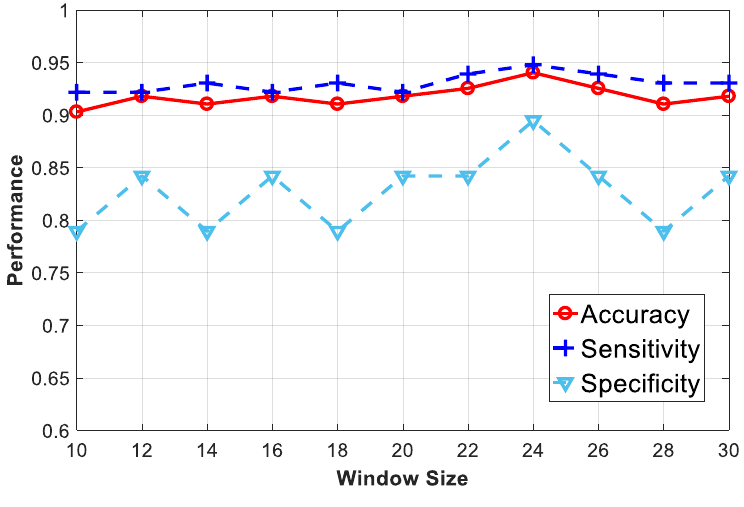
Figure 5. Impact of window size.